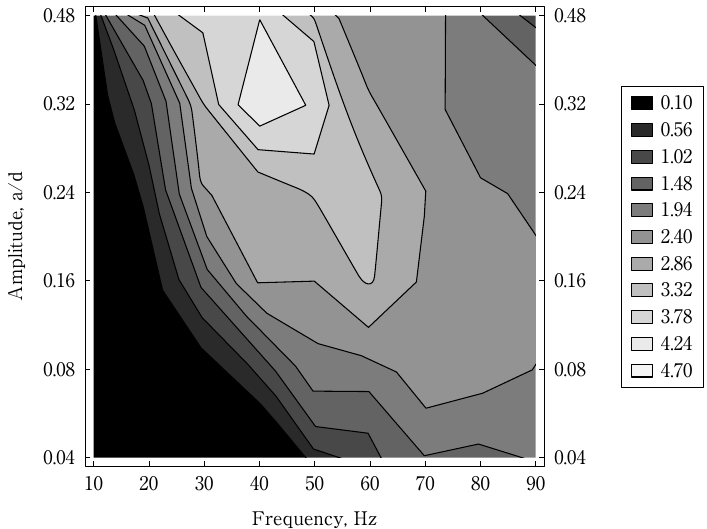
Fig. 11 Chart showing improvement in solids fraction as a function of vibration amplitude and frequency for an 8000 particle system in which L/d =